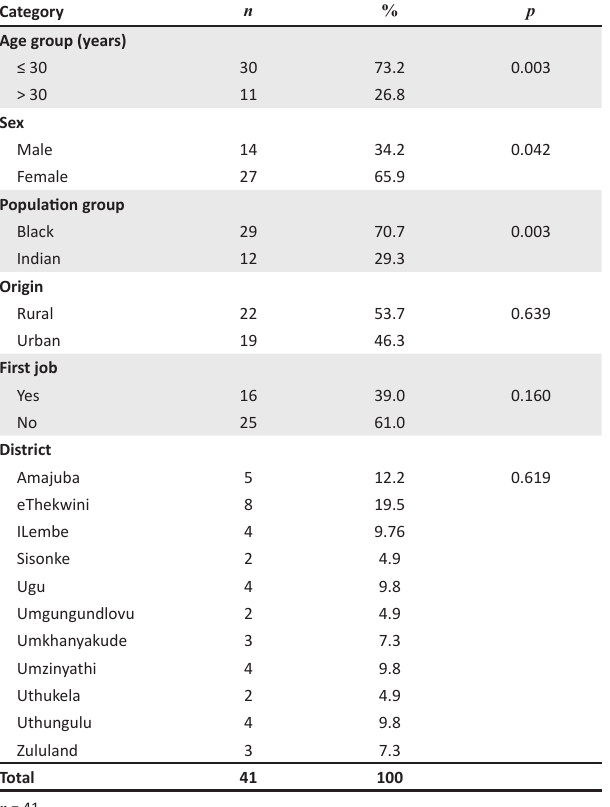
TABLE 1: Demographic profile of participants per health district of KwaZulu- Natal. Category